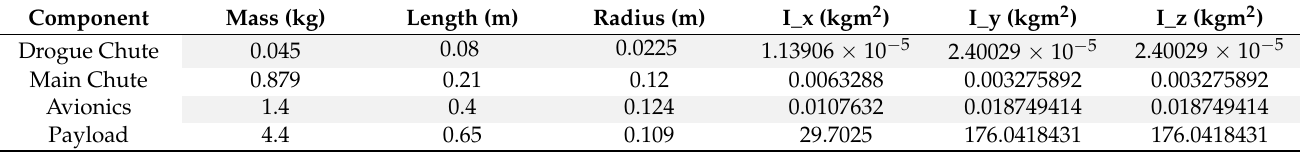
Table 9. Component mass and mass moment of inertia